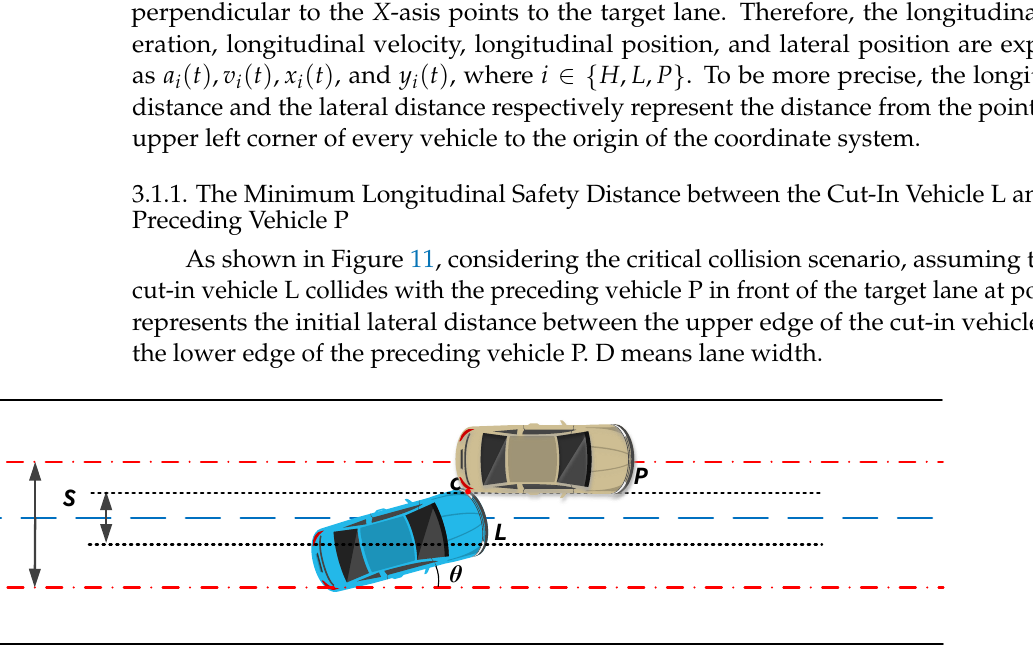
Figure 11. The position of the cut-in vehicle L and the preceding vehicle P.